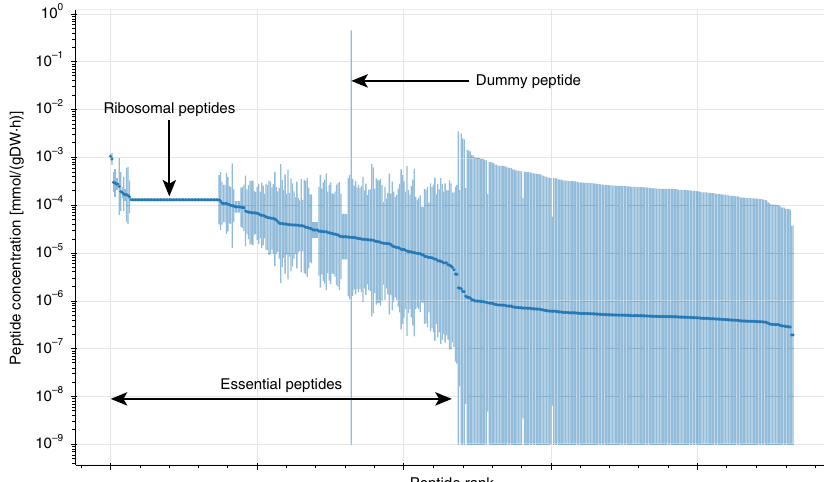
Fig. 2 Concentration variability of peptide species, sorted by average peptide concentration (darker disc). Lower bounds that were 0 were cut off at concentrations of 10 (cid:4) 9 mmol : gDW (cid:4) 1 . The horizontal line on the left side of the fi gure represents ribosomal peptides, which is narrow due to their instrumental role in making the tightly constrained amount of protein in the cell at a given growth rate. The vertical line in the middle represents the dummy peptide, which accounts for unmodeled peptides (non-metabolic proteins and enzymes with missing information) and therefore is used by the solver as a